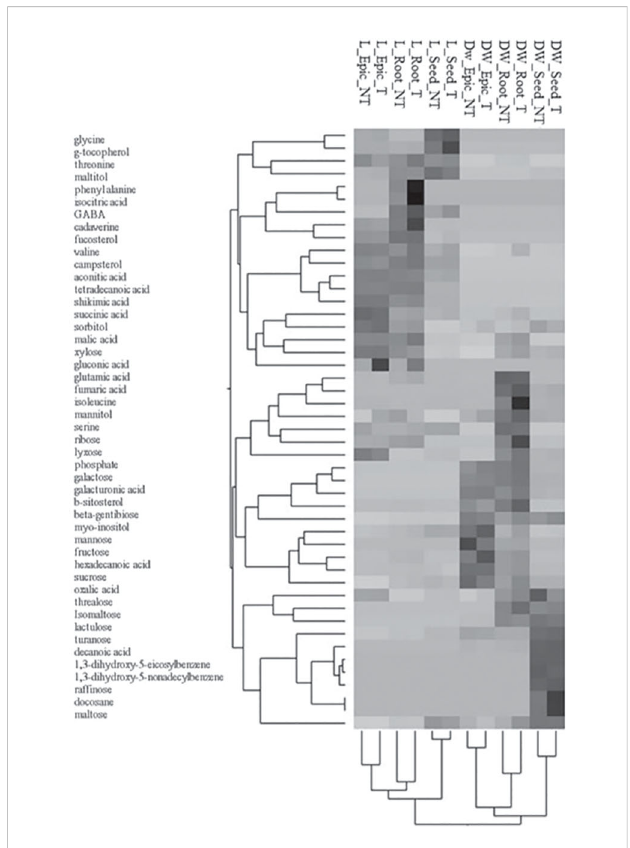
FIGURE 3 Two-way hierarchical clustering (Ward ’ s method) of metabolites data for durum wheat and